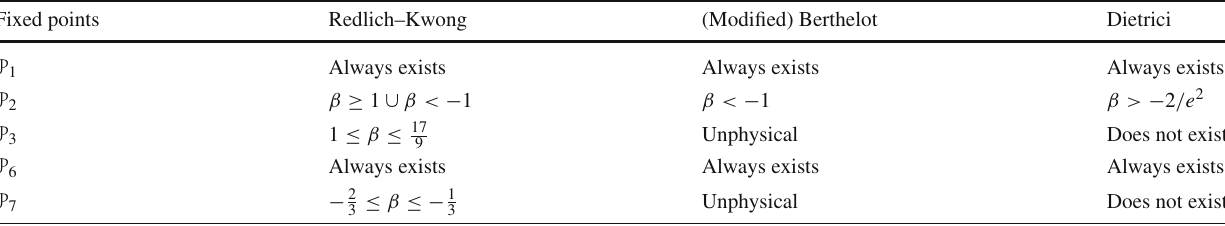
respond to ideal fluid and General Relativity, respectively. The points P P 4 and 5 are not included in this Table because they belong to a region of the phase in which the deceleration parameter is always positive